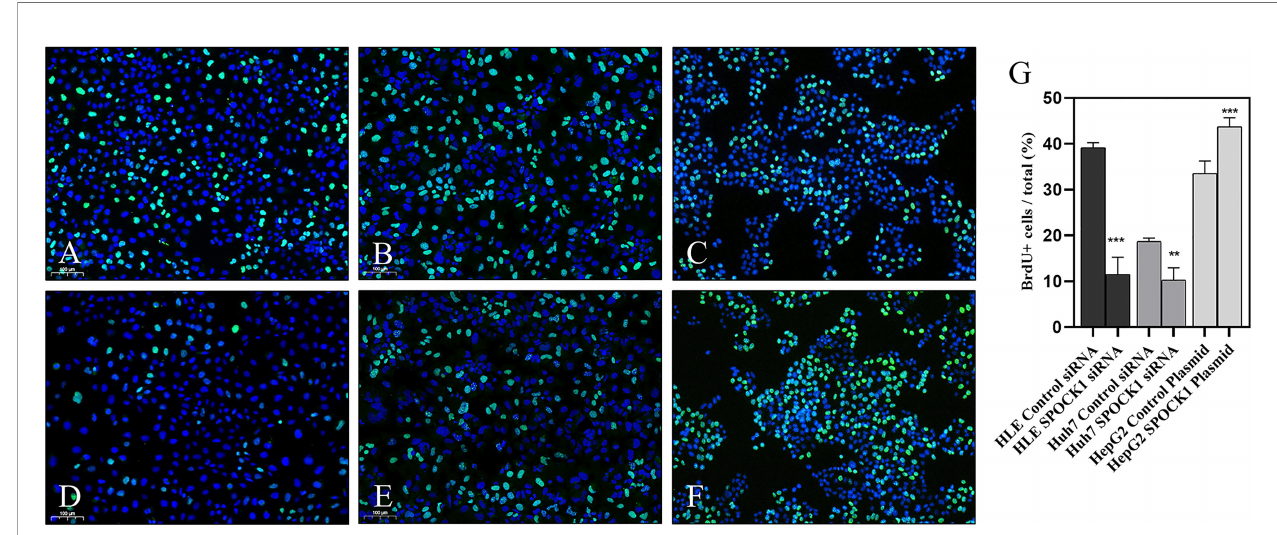
FIGURE 7 | BrdU uptake was studied in HLE and HuH7 cells after silencing SPOCK1 and HepG2 cells overexpressing the proteoglycan. Silencing of SPOCK1 inhibits its upregulation by transfection, promoting BrdU uptake. (A) HLE, (B) HuH7, and (C) HepG2 control cell lines. (D) HLE and (E) HuH7 cell lines transfected with siRNA. (F) HepG2 cell line transfected with the SPOCK1 expression vector. (G) Quantitation of the fl uorescent nuclei. Green BrdU, blue DAPI. Original magni fi cation, ×20. **p < 0.01, ***p <